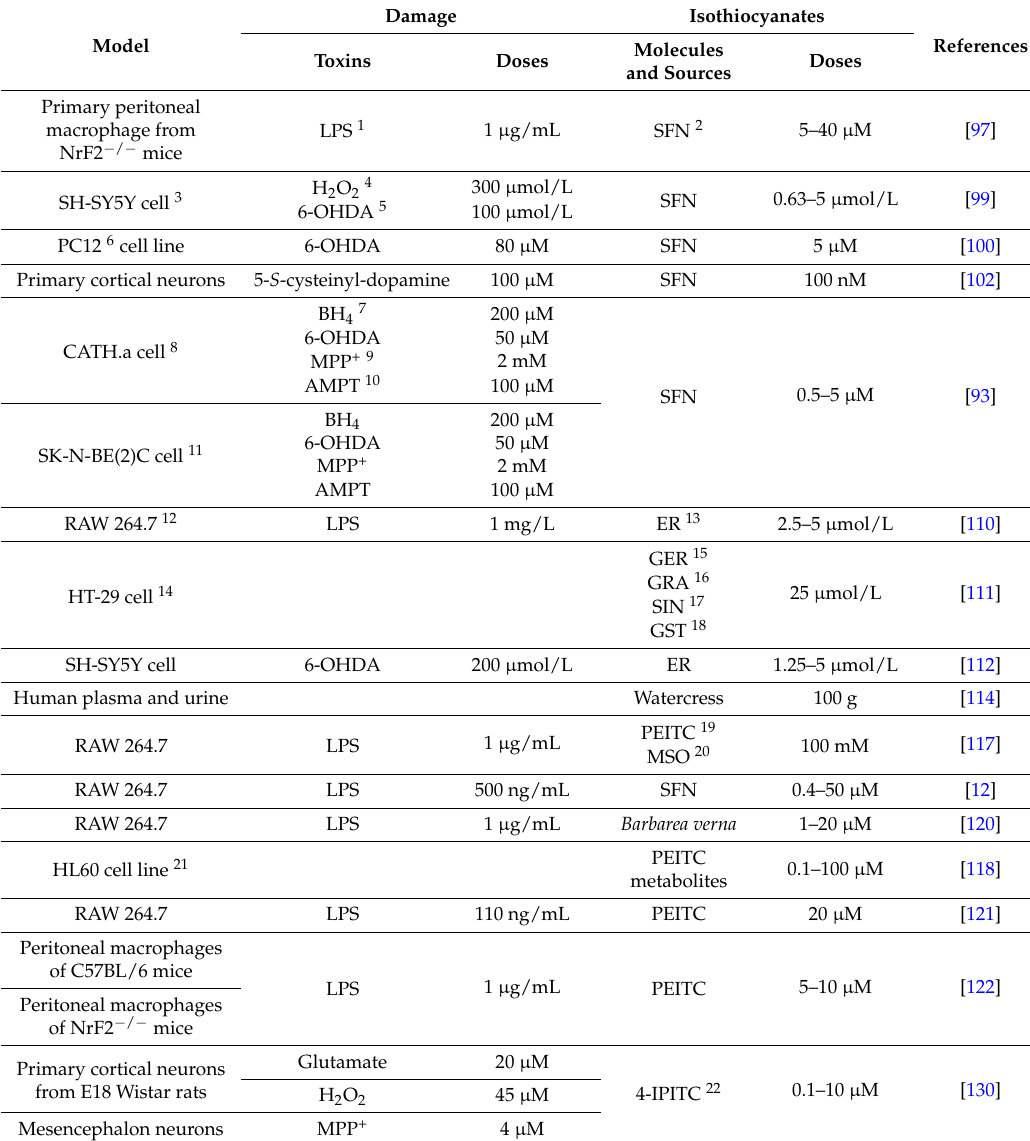
Table 1. Summary of experimental models in vitro and isothiocyanate (ITC)